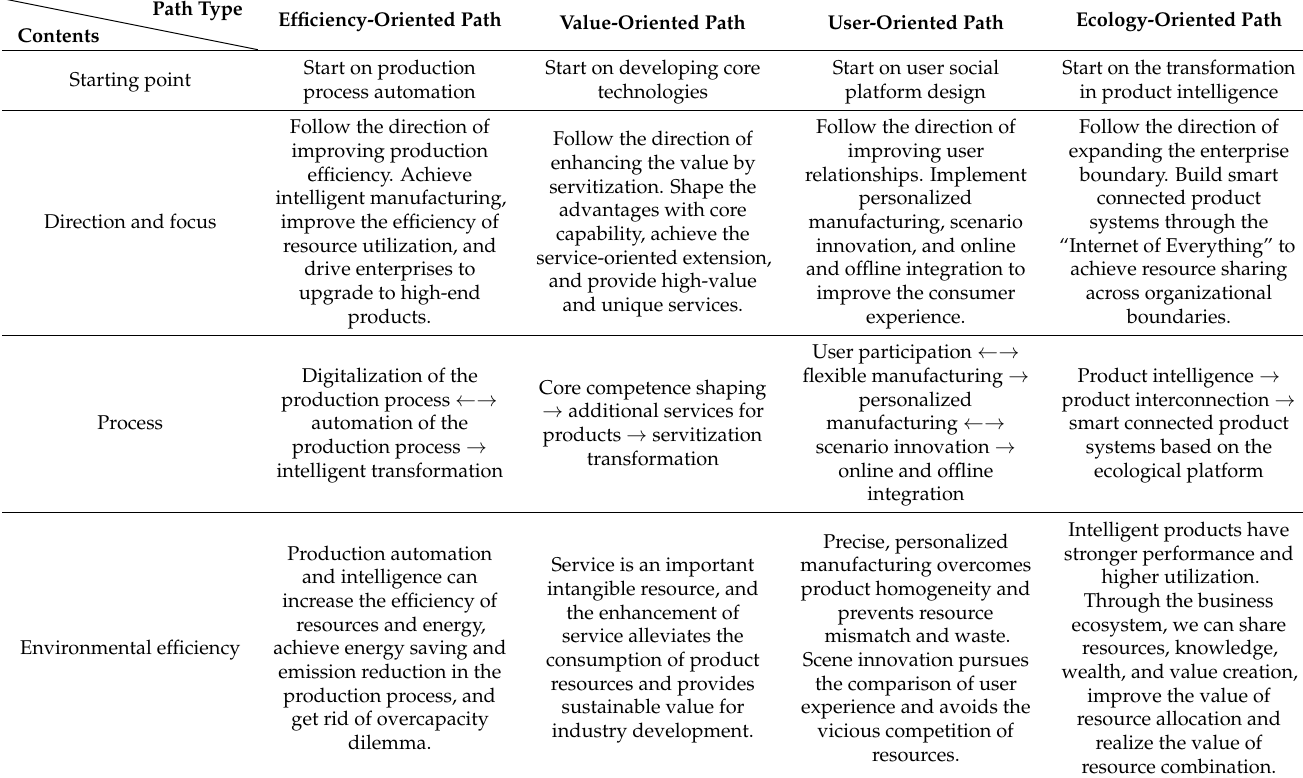
Table 7. Comparison of business model innovation